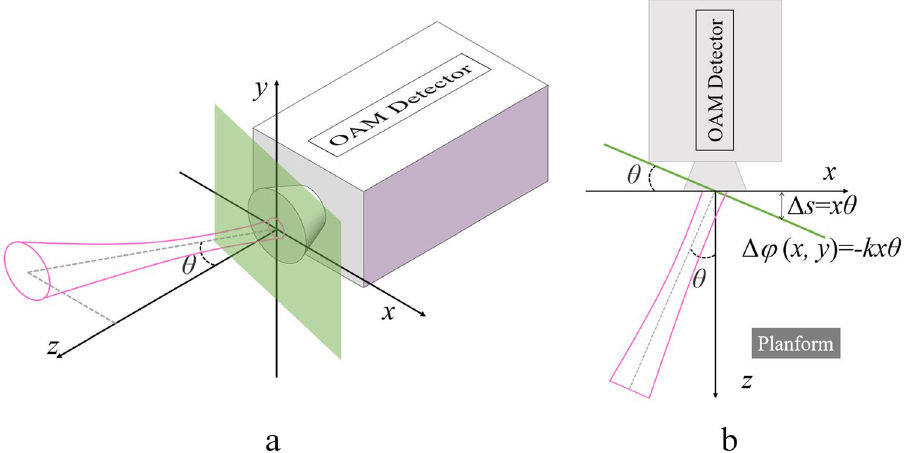
Figure 2. The schematic of ( a ) the 3-D view and ( b ) top view along y -axis of the simplified case that the incident light beam carrying OAM is in the x-z plane ( η =